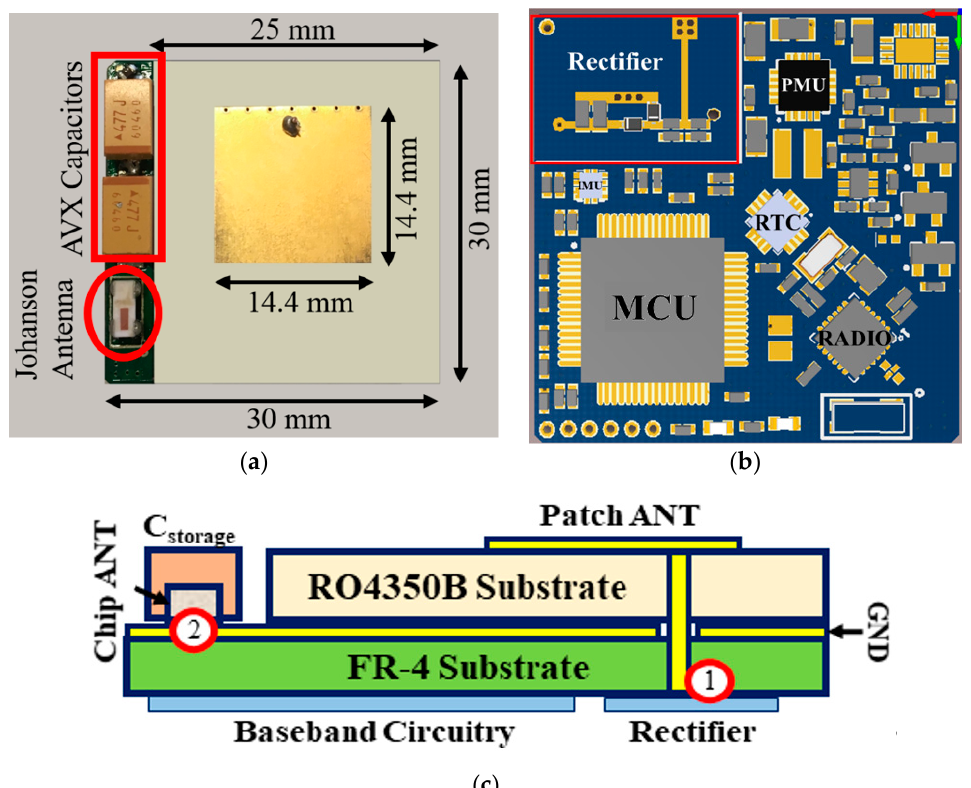
Figure 4. ( a ) Picture of the top layer of the tag, in which it is possible to notice the shorted patch antenna for WPT, the metal-mounted chip antenna, and the storage capacitors; ( b ) bottom layer of the node, with the highlight of the main components and the RF-to-DC rectifier; ( c ) stack-up of the whole sensor node, with the antennas and the capacitors placed on the top layer, the RF and baseband components on the bottom, and the plated through-hole (PTH) connecting patch and rectifier.